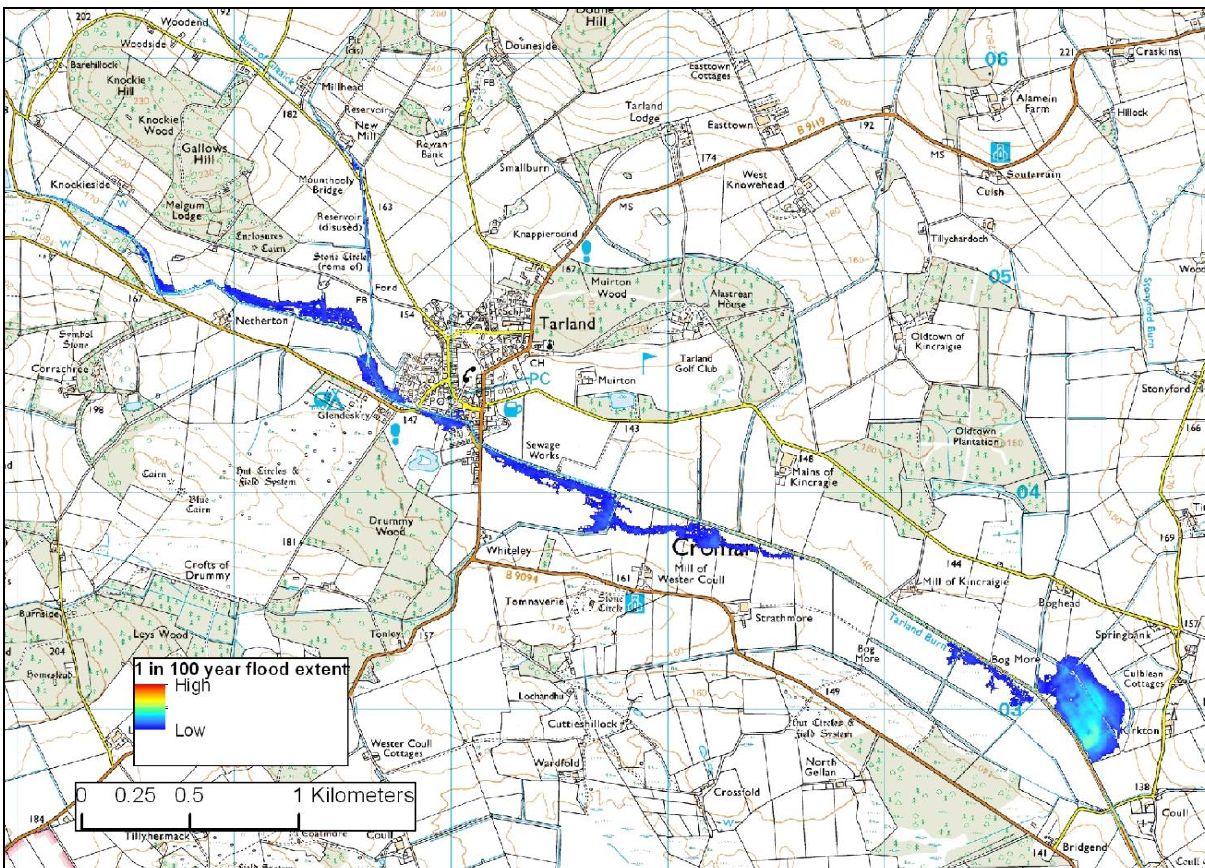
Figure 7. 1 in 100 year extreme flood inundation of Tarland.